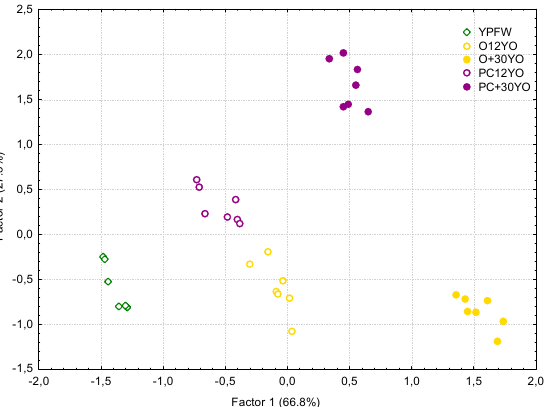
behind each one was facilitated after the varimax rotation of the factors. The analyses de-